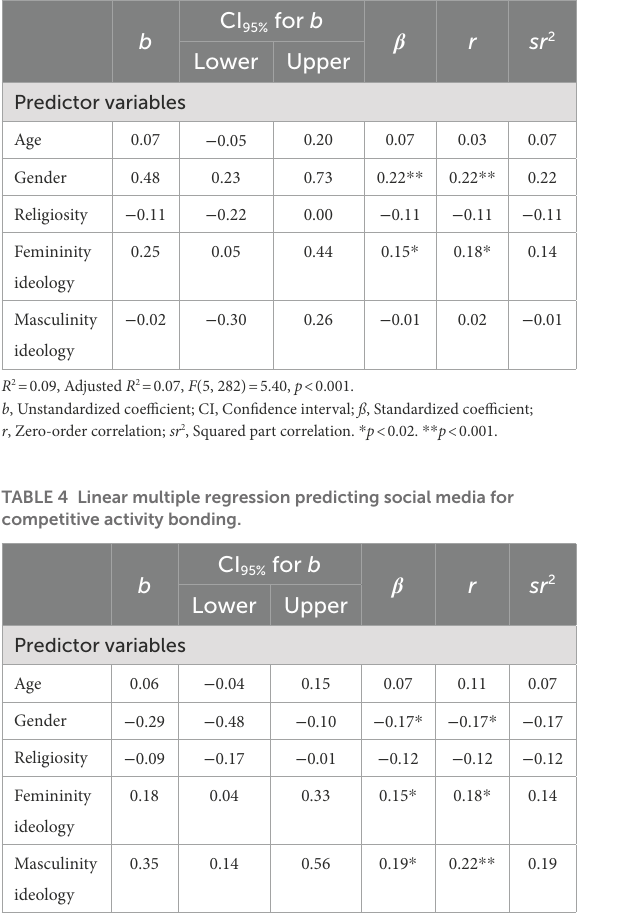
TABLE 3 Linear multiple regression predicting social media for emotion bonding.